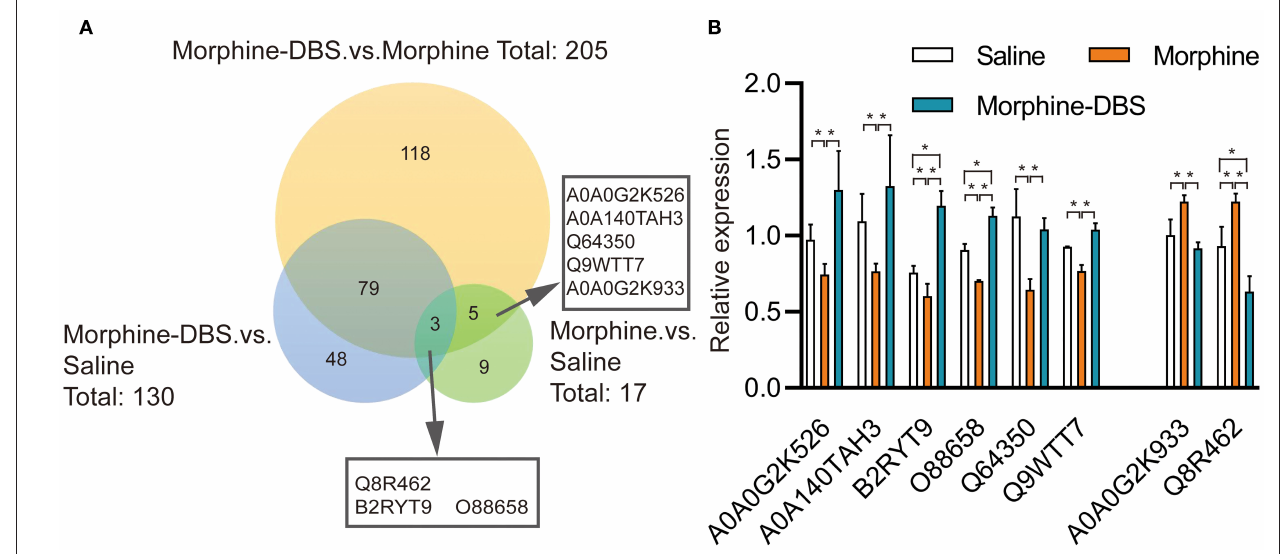
FIGURE 5 | HF-DBS reverses the expression of morphine addiction-related proteins in the anterior insula during the withdrawal phase. (A) Venn diagram for the number of differentially expressed proteins (DEPs) identified by the three comparisons morphine-DBS vs. morphine, morphine vs. saline and morphine-DBS vs. saline. Eight DEPs were identified commonly in the two comparisons (morphine-DBS vs. morphine and morphine vs. saline) and 3 out of 8 DEPs were also identified in the morphine-DBS vs. saline comparison. (B) Relative expressions of 8 differential expressed proteins among saline, morphine, and morphine-DBS groups. Six proteins (A0A0G2K526, B2RYT9, A0A140TAH3, O88658, Q64350, and Q9WTT7) were significantly down-regulated in the morphine group as compared with the saline group (morphine vs. saline, p < 0.05) but up-regulated in the morphine-DBS (morphine-DBS vs. morphine, p < 0.05), whereas two proteins (A0A0G2K933 and Q8R462) increased in the morphine group (morphine vs. saline, p < 0.05) but decreased in the morphine-DBS (morphine-DBS vs. morphine, p < 0.05). The expression of differentially expressed protein was assessed with unpaired Student’s t -tests. * p < 0.05. n = 3 for saline, morphine, and morphine-DBS groups. TABLE 1 | The list of differentially expressed proteins in the anterior insula that overlap between morphine vs. saline and morphine-DBS vs. morphine and morphine-DBS vs. saline comparison. Protein ID Protein name Morphine vs. Saline Morphine-DBS vs. Morphine Morphine-DBS vs. Saline P -value Down/Up Fold P -value Down/Up Fold P Down/Up Fold Change Change Change